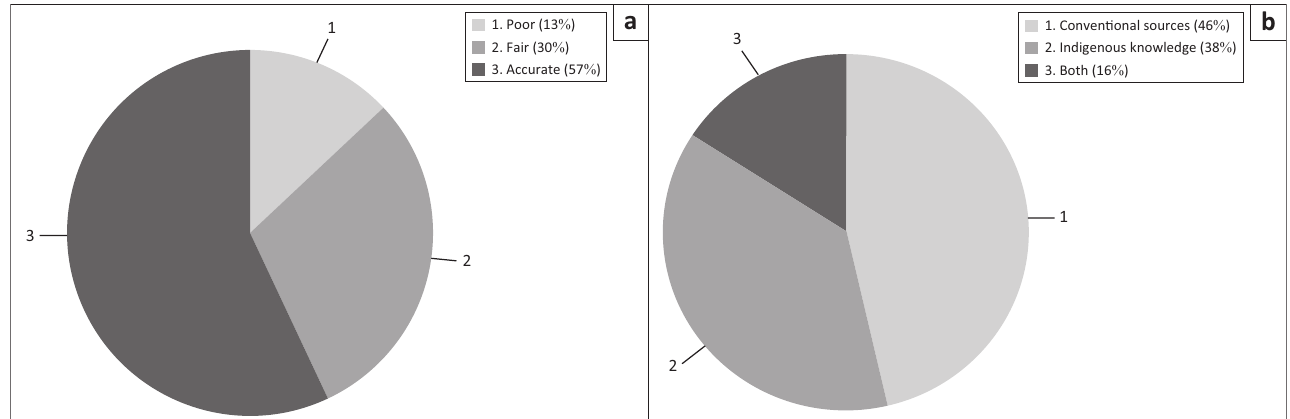
FIGURE 4: (a) Household’s perceptions of accuracy of indigenous indictors for seasonal weather forecasting and (b) preferences on sources of seasonal weather forecasting ( n = 217).